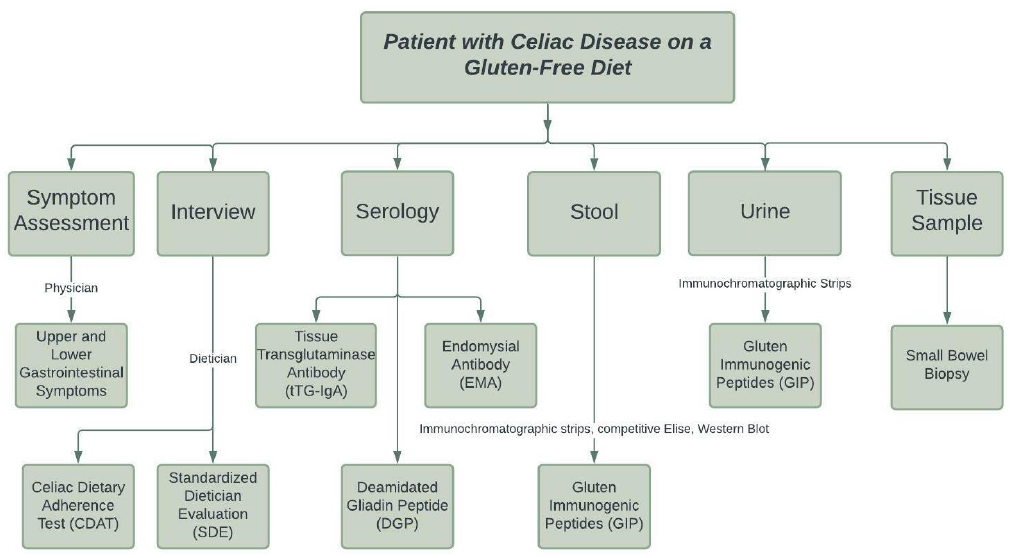
Figure 1. Methods for monitoring adherence to gluten-free